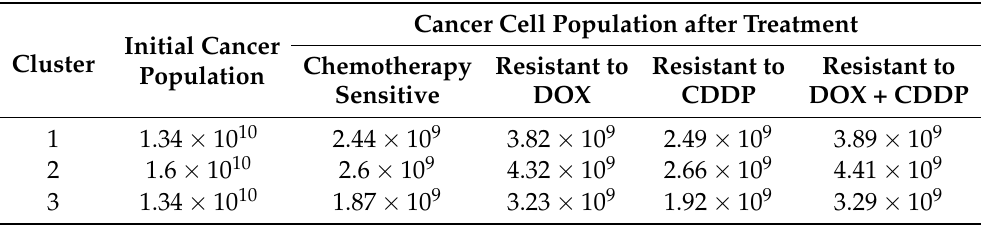
Table 3. Cancer cell populations after MAP treatment with chemotherapy-resistant